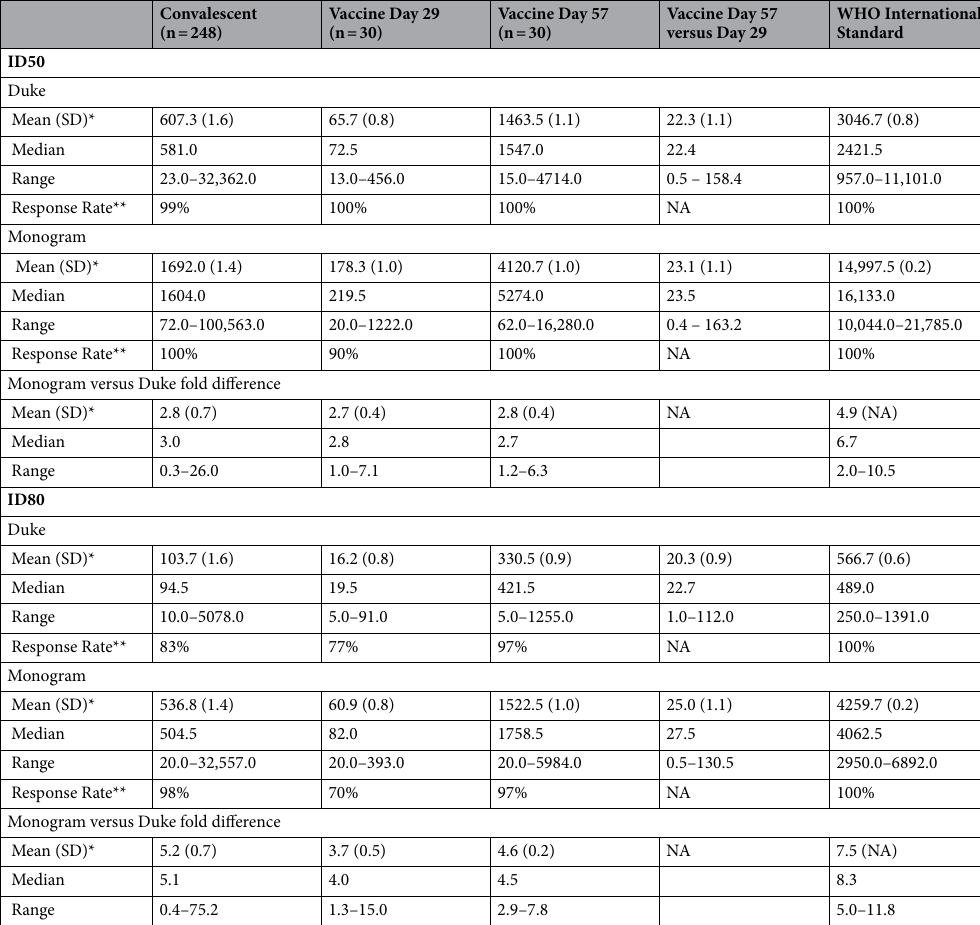
Table 2. Summary of pre-calibration ID50 and ID80 titers measured by the Duke and Monogram labs and their fold-differences for convalescent patient sera, Day 29 vaccinee sera, Day 57 vaccinee sera, and the WHO International Standard sample. * Geometric mean of titers or titer ratios and standard deviation of the log e - transformed titers or titer ratios. **Proportion of samples with an ID50 or ID80 titer above the assay